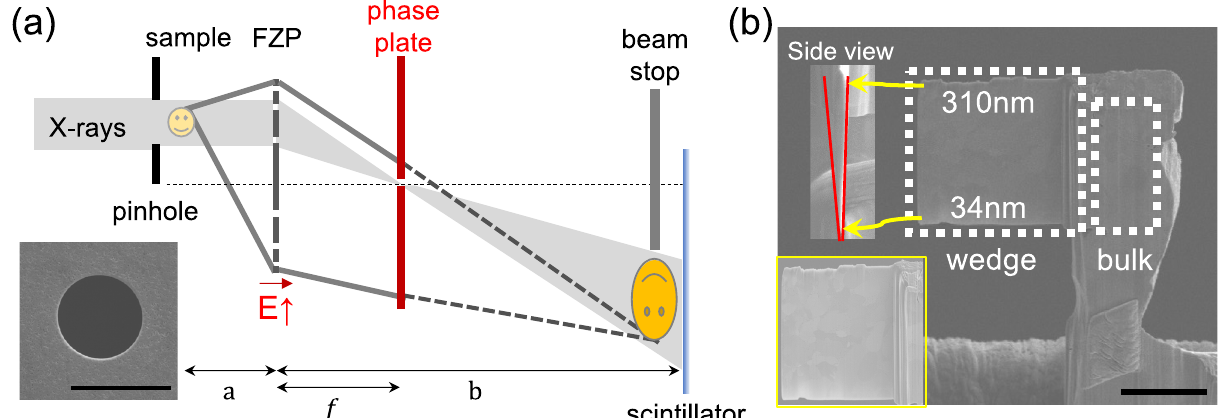
Figure 1. Acquisition of ZPC-XANES. ( a ) Schematic of the off-axis full-field phase contrast XANES spectroscopy setup. The inset shows the 4 μm hole on the Au phase plate. ( b ) Scanning electron microscope (SEM) images of the Cu reference sample with wedge-shaped structures and bulk Cu. The side view shows the thickness where the beam passes through at the wedge structure with the top with a thickness of 310 nm and the bottom with a thickness of 34 nm. The inset shows the adjusted contrast of wedge Cu. The scale bars are 5